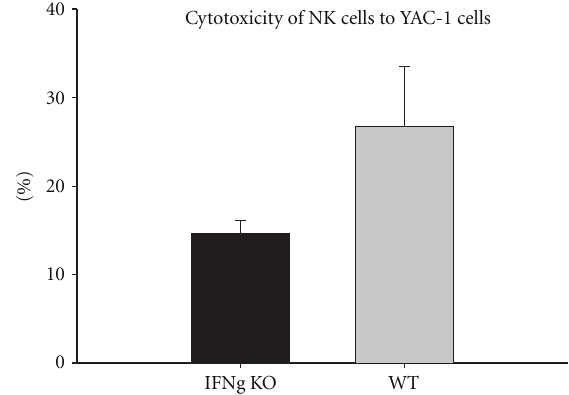
Figure 8: Cytotoxicity of NK cells exposed to YAC-1 cells from IFNg KO and WT mice immunized with